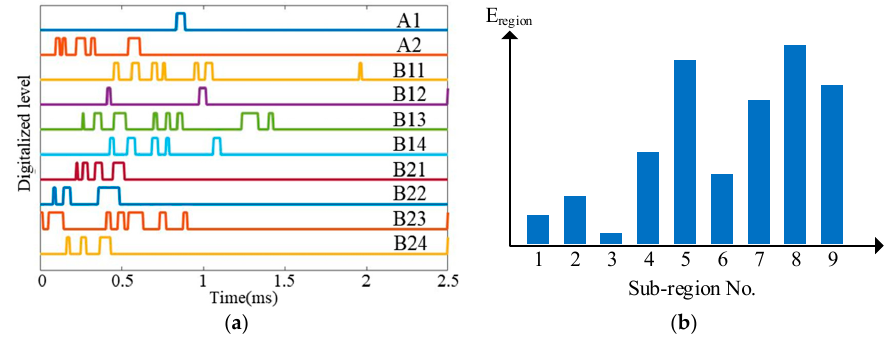
Figure 16. Impact region localization results based on the CHSN: ( a ) CDSs and ( b ) E region of sub-regions.